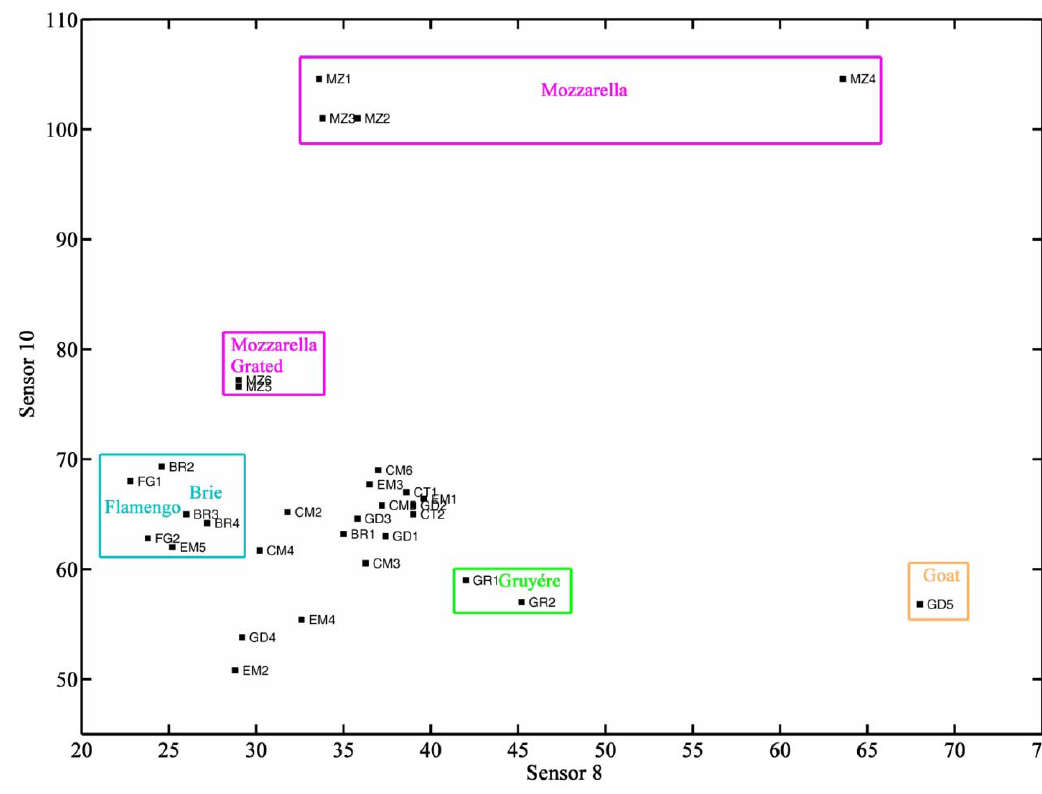
Figure 7. Plot of the responses of sensor 10 vs. sensor